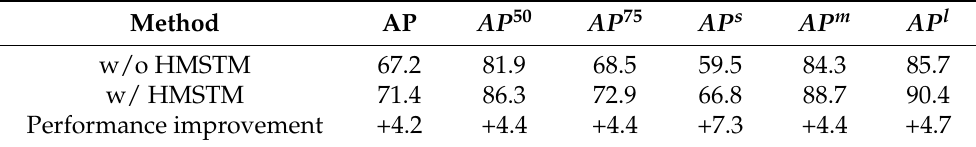
Table 4. Validation experiments on the hierarchical multi-scale training mechanism (HMSTM).